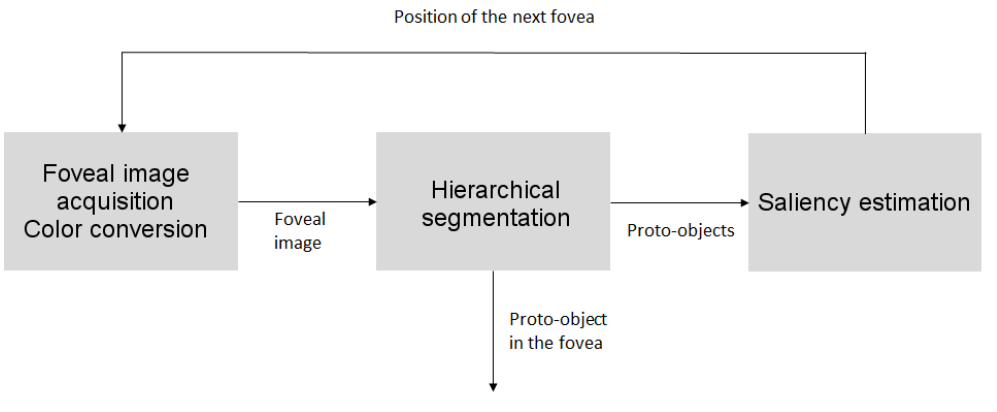
Figure 2. Overview of the proposed framework.